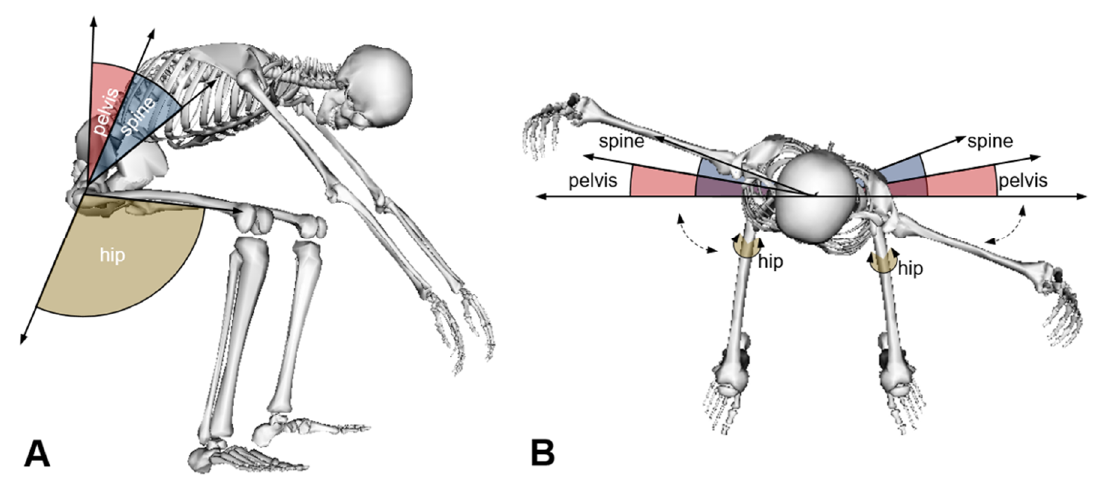
Figure 2. ( A ) Lateral view representation of sagittal joint kinematics assessment during SBR: spine flexion, pelvis tilt, and hip flexion. Spine flexion is the angle between the sagittal thorax axis and the sagittal pelvis axis around the fixed transverse axis of the pelvis. Pelvic tilt is measured as the angle in the transverse plane between the projected sagittal pelvic axis and the sagittal laboratory axis. Hip flexion is the angle between the projected sagittal thigh axis and the sagittal pelvic axis. ( B ) Superior view representation of axial joint kinematics assessment during STR: left and right spine rotations, left and right pelvis rotations, and left and right hip rotations. Spine rotation is measured as the angle between the sagittal axis of the thorax and the sagittal axis of the pelvis, around a floating frontal axis. Pelvis rotation is the angle measured between the sagittal axis of the pelvis and the sagittal laboratory axis projected into the pelvis transverse plane. Hip rotation is calculated between the sagittal axis of the thigh and the sagittal axis of the pelvis projected into the plane perpendicular to the long axis of the thigh.